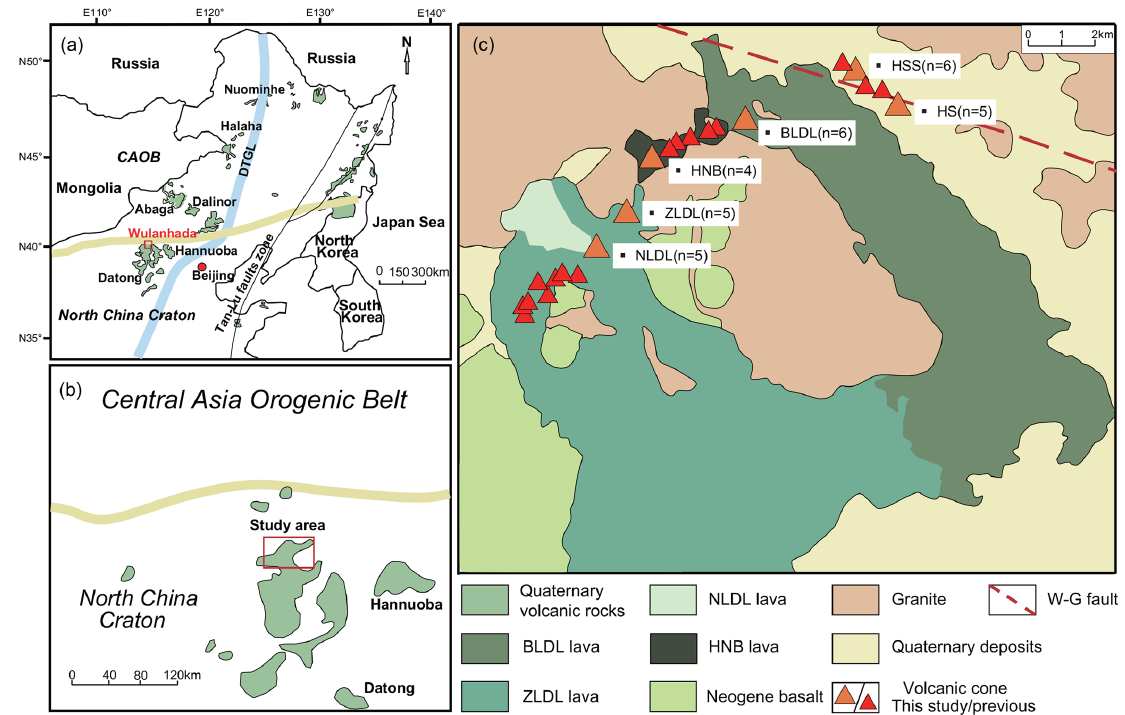
Figure 1. (a) Map of northeastern China showing the distribution of Cenozoic basalts and the location of the Wulanhada Volcanic Field (WVF; modified after Zhao et al., 2019). The light blue band marks the Daxing’anling–Taihangshan gravity lineament (DTGL); the yellow band shows the block boundary. CAOB refers to the Central Asian Orogenic Belt. (b) Schematic geological map of the WVF and adjacent area (modified from Ma, 1989). (c) Geological map of the WVF showing locations of Quaternary volcanoes, adapted from Bai et al. (2008) and Fan et al. (2014). W–G fault refers to the Wulanhada–Gaowusu fault. HS, Hongshan; HSS, Huoshaoshan; BLDL, Beiliandanlu; HNB,